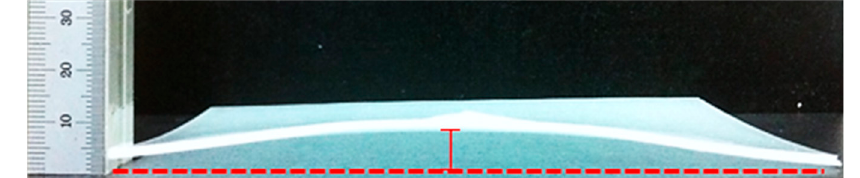
Figure 2. Method of measuring the warpage of a specimen using height meter.